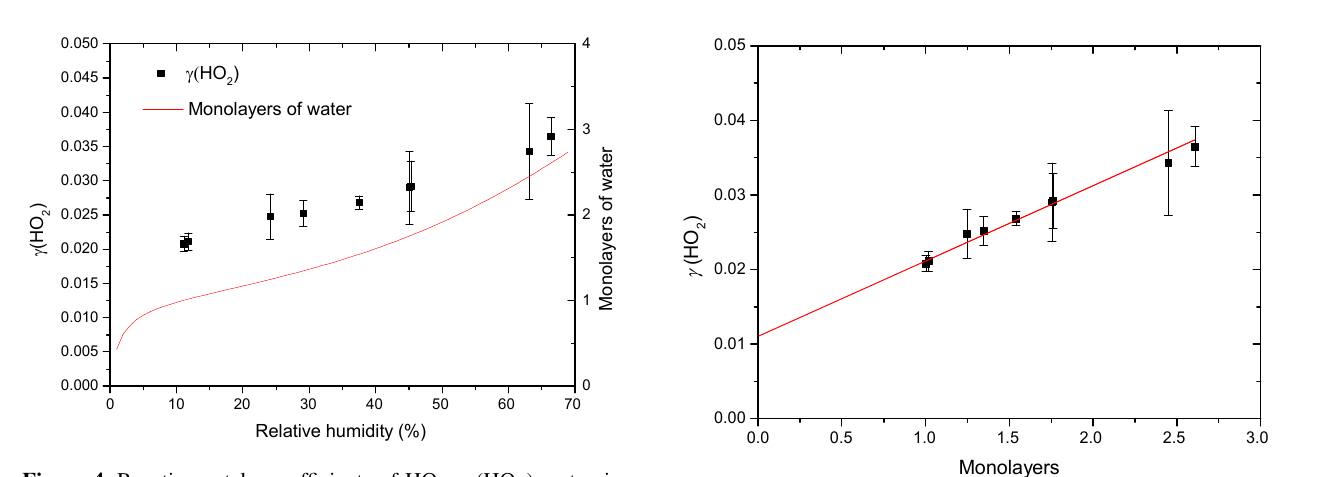
Figure 5. Variation of the reactive uptake coefficient, γ (HO 2 ), with the number of monolayers of water surrounding TiO 2 particles (as determined by Goodman et al., 2001) for T = 295 ± 2K. The red line represents a linear least-squares fit to the data ( r 2 =